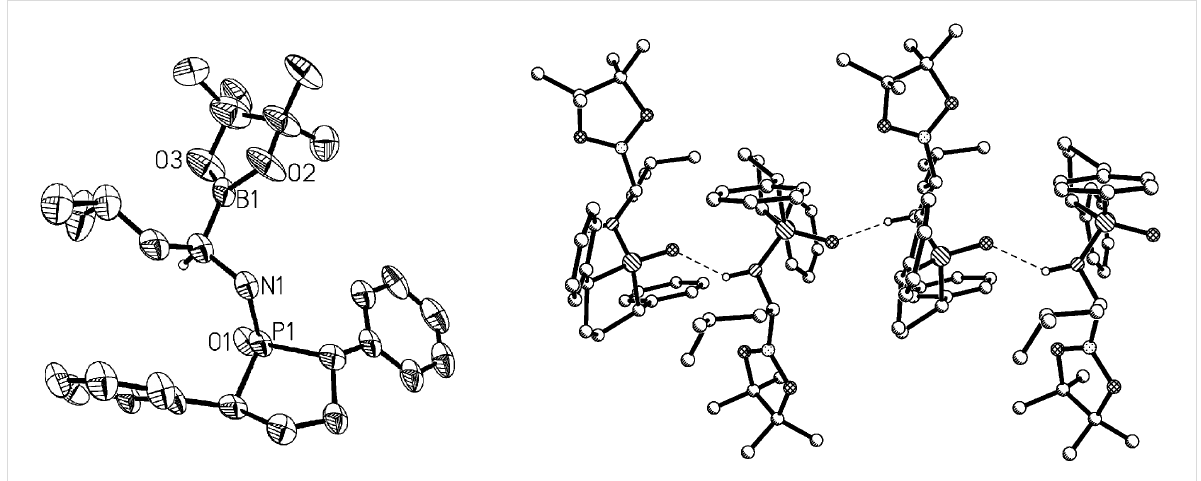
Figure 1: ORTEP diagram of ( S , S , R )- 3a (left, most of the hydrogen atoms were omitted except the one on the chiral center connected to boron) and the H-bonds between the molecules (right). Selected bond lengths [Å] and angle [ o ]: P1–O1 1.505, P1–N1 1.613, N1–H1, 0.957, B1–O2 1.368, the H-bond O1···H2 1.990; the angle of H bond N1–H1···O4